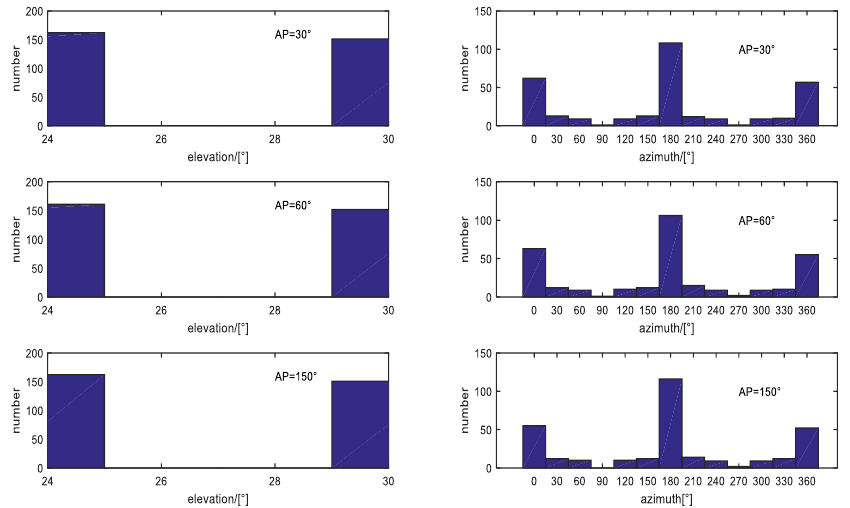
Figure 12. Variations in the elevation angle and azimuth with AP .